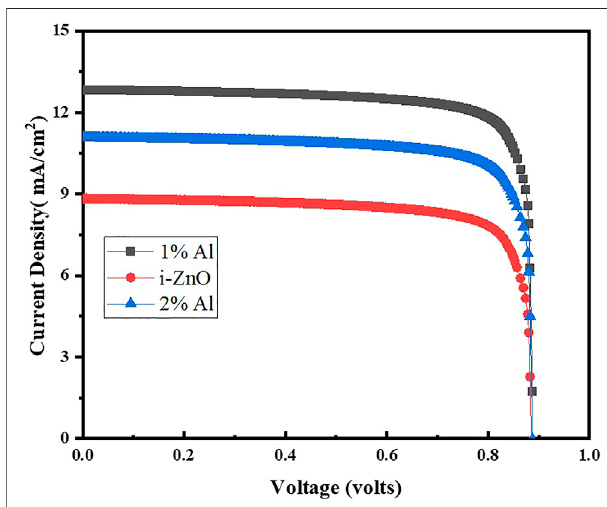
FIGURE 8 | IV characteristics of fabricated